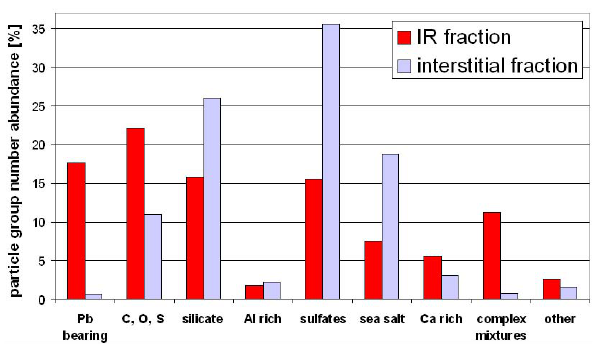
Fig. 1. Average particle group number abundance within ice resid- uals (IR) and interstitial samples within mixed phase clouds ( d P ≥ 0 . 7µm)for cloud events 1–3 (C, O, S = soot/secondary material mix- tures; 3 / 3 of the complex mixtures contain silicates and/or metal ox-